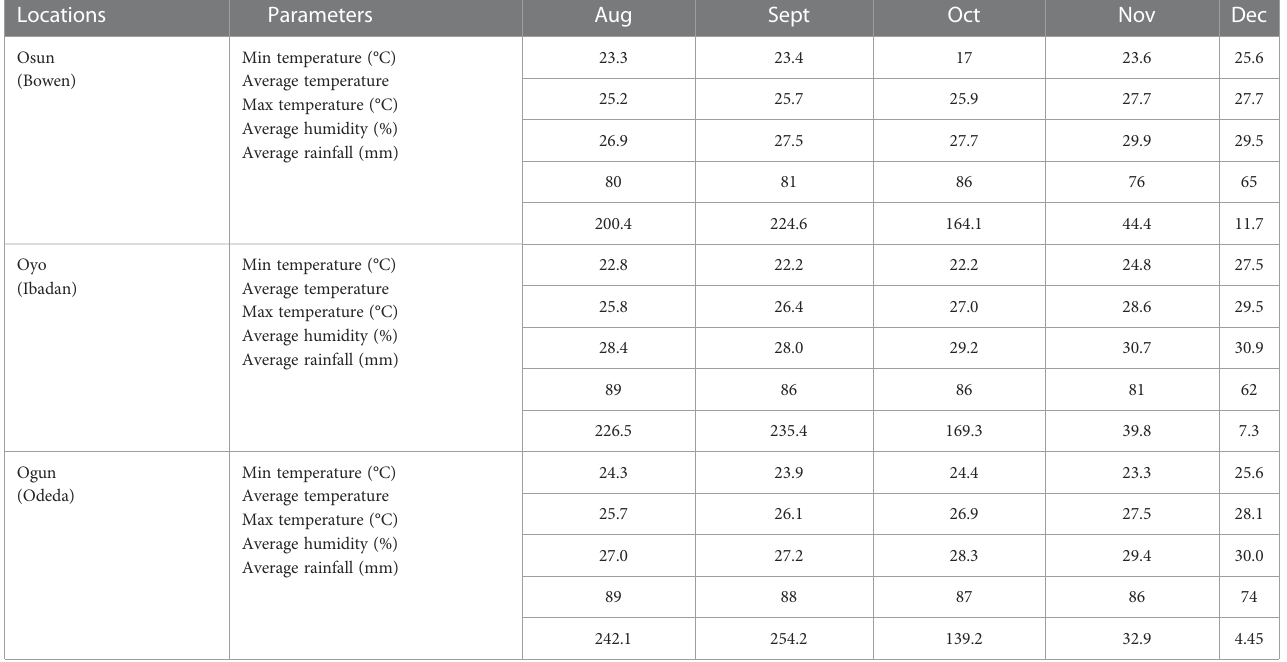
TABLE 1 Average climatic conditions in the three locations during the experiments.